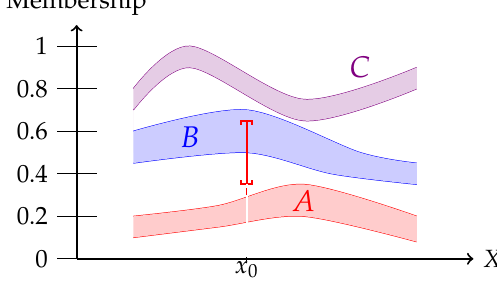
Figure 3. Membership degrees for A , B and C